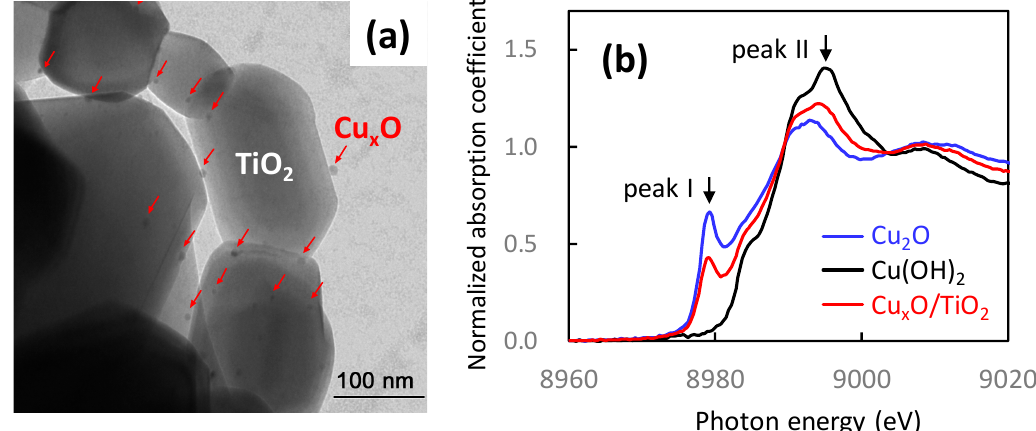
Figure 10. ( a ) TEM image of Cu x O/TiO 2 and ( b ) XANES spectra of Cu 2 O, Cu(OH) 2 , and Cu x O/TiO 2 [33].